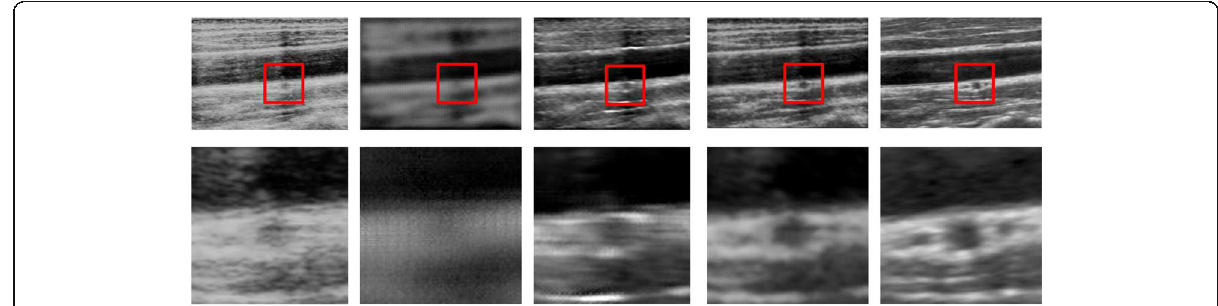
Fig. 9 Results of in vivo carotid data. On the first line from left to right are low-quality image, encoder-decoder result, U-Net result, SSC U-Net result, and high-quality image correspondingly. The second line shows the image in the corresponding red box in the first